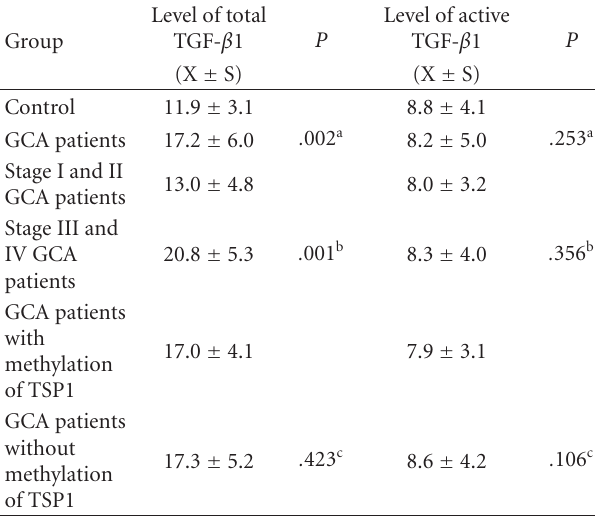
with hypermethylation of TSP1 than that in the GCA patients without hypermethylation of TSP1, but did not show significant di ff erence (7.96 ± 3.18 μ g/L versus 8.65 ±